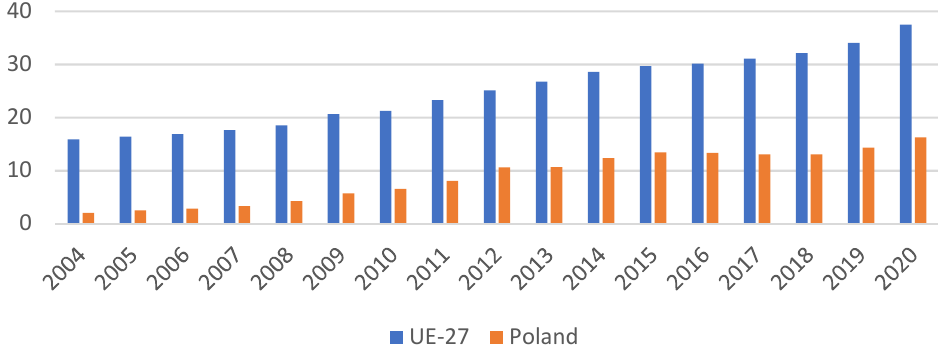
Figure 2. Share of energy from renewable sources in gross electricity consumption in Poland and UE-27 [%]. Source: [7].